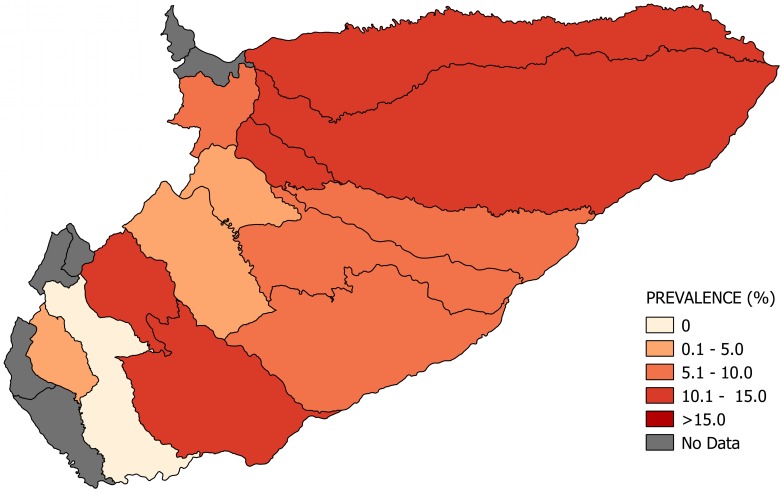
Map of the municipalities of Casanare showing the distribution of observed Chagas disease prevalence in studies published from 2007 to November 2017.